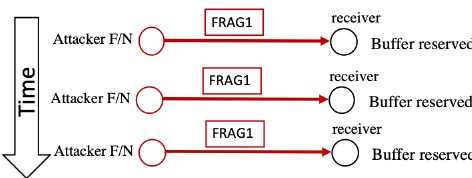
Figure 9. Buffer reservation